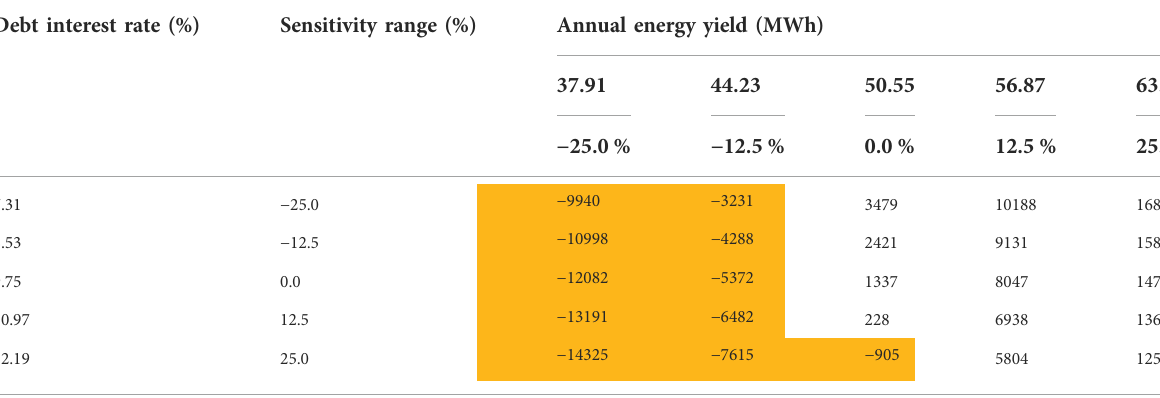
TABLE 9 Sensitivity analysis results for NPV of solar PV project in Rawalpindi. Case 1: Variation of debt interest rate vs. annual energy